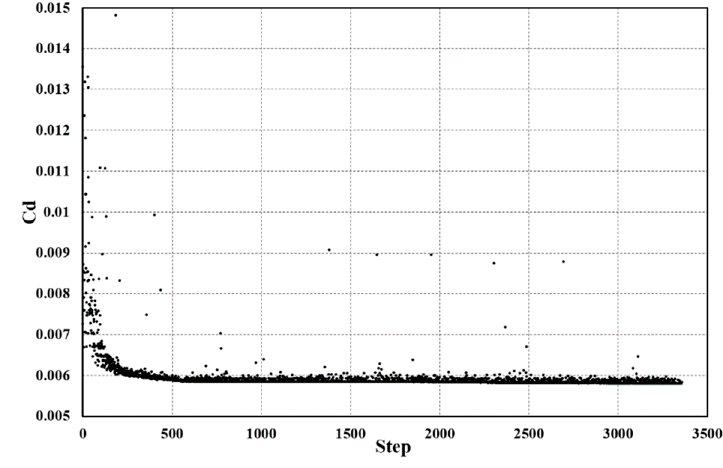
Figure 9. Normal optimization convergence process.